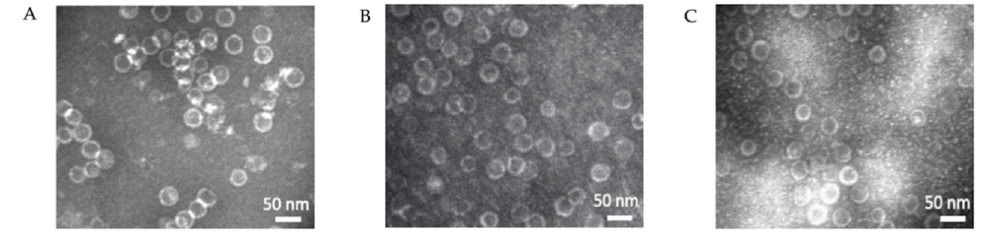
Figure 5. Scanning transmission electron microscopy of tHBcAg VLPs. ( A ) tHBcAg VLPs before treatment; ( B ) tHBcAg VLPs conjugated with folic acid (FA ‐ tHBcAg); and ( C ) tHBcAg VLPs encapsidating PshRNA and conjugated with folic acid (FA ‐ tHBcAg ‐ PshRNA).